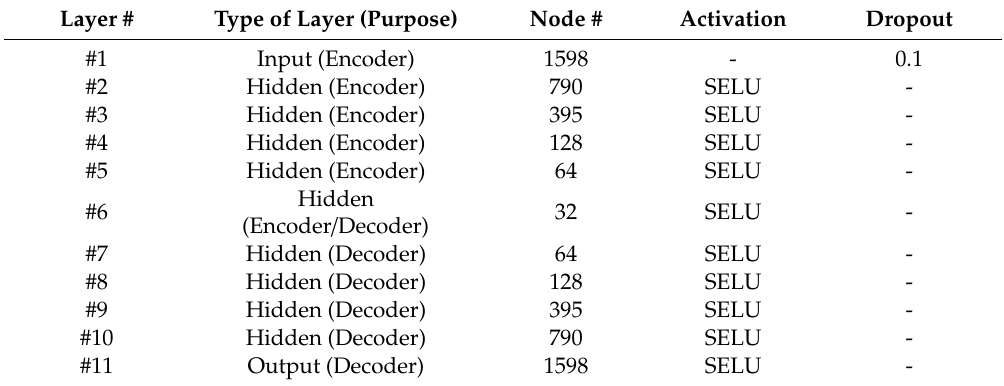
Table 2. The architecture of the proposed deep undercomplete denoising autoencoder